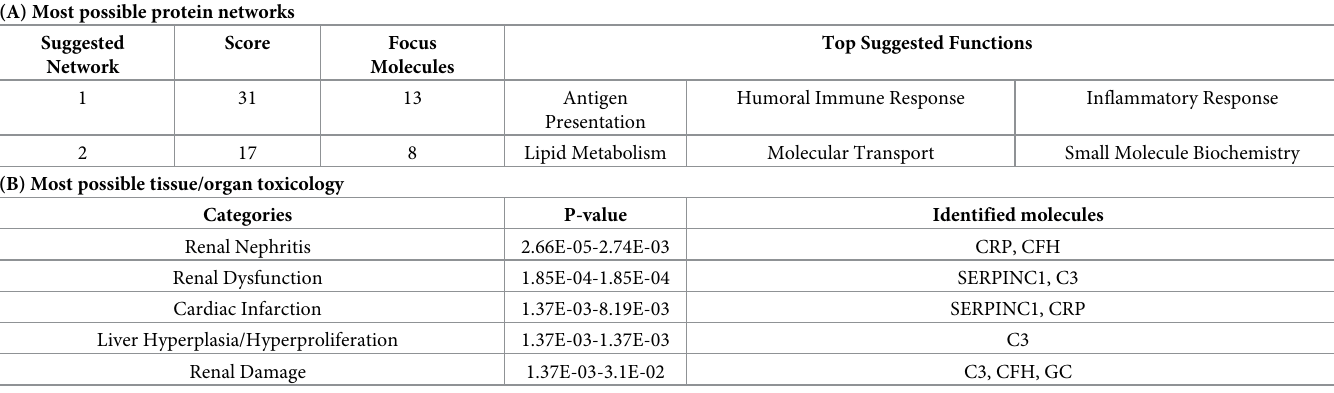
(A) The top 2 related protein networks and correspondingly involved biological functions suggested by the Ingenuity Pathway Analysis (IPA) software. (B) The top 5 related tissue/organ toxicology suggested by IPA.